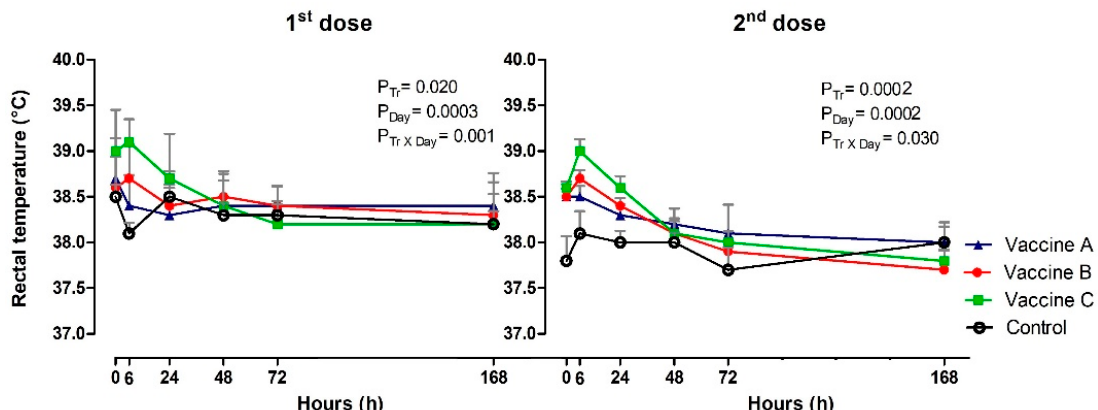
Figure 3. The figure represents the mean values and standard deviations of systemic vaccine by rectal temperature (°C) in animals vaccinated with three different formulation adjuvanted vaccines against BVDV and BHV-1.Overall statistical significance ( p ≤ 0.05) is indicated in the plot as follows: Effects of treatment (P tr ), day (P Day ) and interactions (P tr x P Day ).